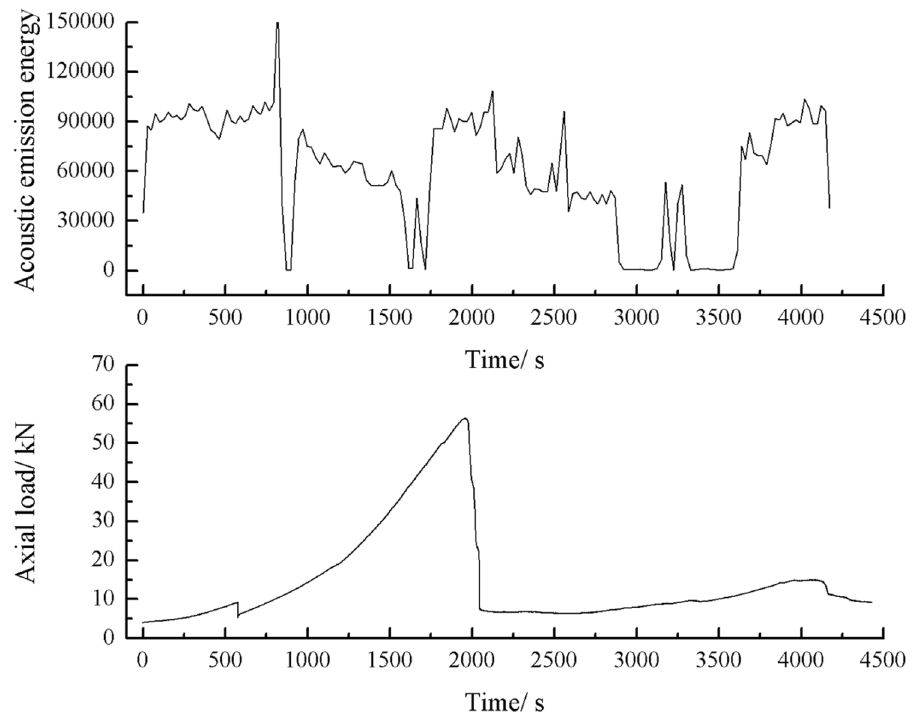
Figure 46. Acoustic emission energy-Axial load of the specimen with 3 cm